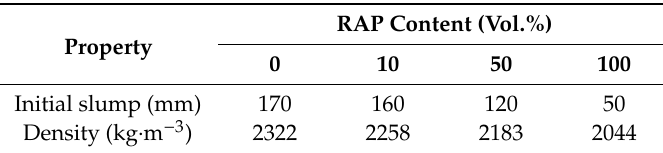
Table 5. Properties of fresh concrete mixes.